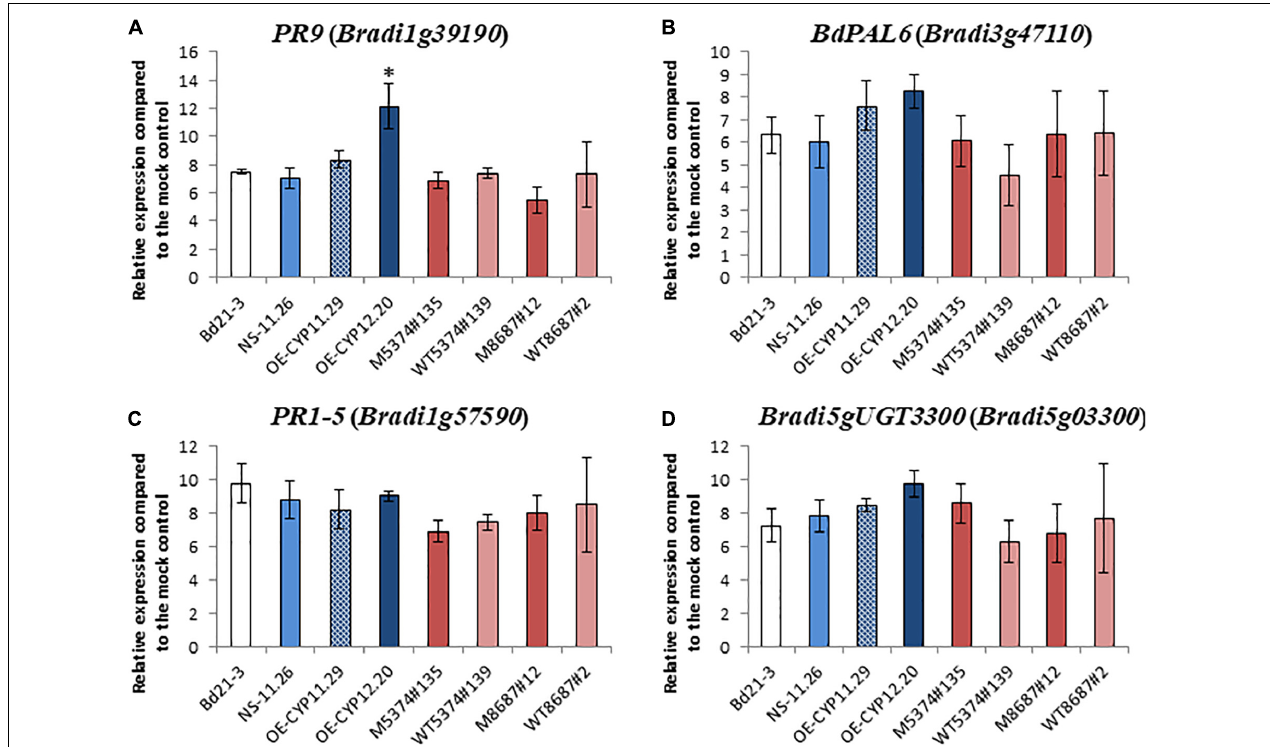
FIGURE 8 | Relative defense gene expression levels in B. distachyon lines altered in BdCYP711A29 following F. graminearum infection compared to mock condition. Relative quantification (fold-change, log 2 ) of the PR9 ( Bradi1g39190 ), (A) , BdPAL6 ( Bradi3g47110 ), (B) , PR1-5 ( Bradi1g57590 ), (C) , and Bradi5gUGT3300 ( Bradi5g03300 ), (D) expression levels in the B. distachyon lines altered in the BdCYP711A29 locus or gene expression 96 hours after F. graminearum infection ( FgDON + strain) compared to mock treatment. The relative quantity of gene transcripts compared to mock condition was calculated using the comparative cycle threshold (Ct) method (2 − (cid:49)(cid:49) Ct ). The B. distachyon UBC18 and ACT7 genes ( Bradi4g00660 and Bradi4g41850 ) were used as endogenous controls to normalize the data for differences in input RNA between the different samples. Mean of three independent biological replicates ± standard deviation. The asterisk (A) indicates significant differences (Student’s t- test, p value < 0.05). No difference was shown to be statistically significant under more stringent conditions (Student’s t- test, p value <